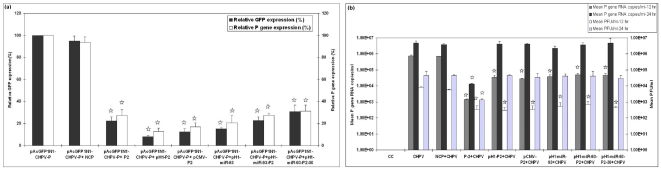
Validation and comparison of efficiency of P-2 siRNA with different P-2 shRNA.(a) Validation of different shRNA expressing plasmids with pAcGFP1N1-CHPV-P by using FACS and real time one step RT-PCR and (b) Efficiency of different shRNA expressing plasmids in modulating CHPV replication at 12hr and at 24hr determined by real time one step RT-PCR and plaque assay. Results are expressed as means ± SD. * indicates significantly different from control at p<0.05 by Dunnett's test.